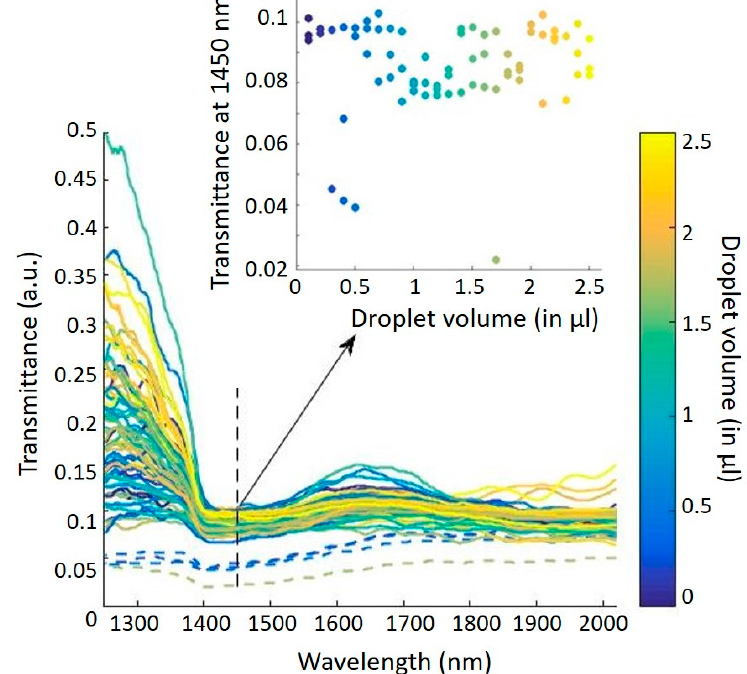
Figure 4. Transmittance spectra obtained from measurements. Outliers are highlighted in dashed lines. The insert shows the transmittance at 1450 nm for each volume.